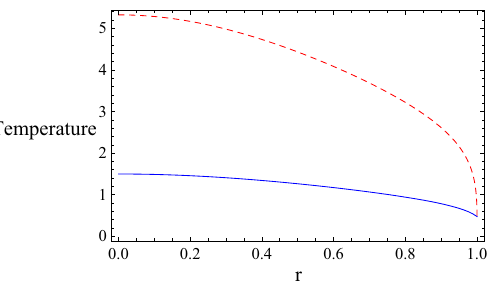
Fig. 6 Energy condition 2